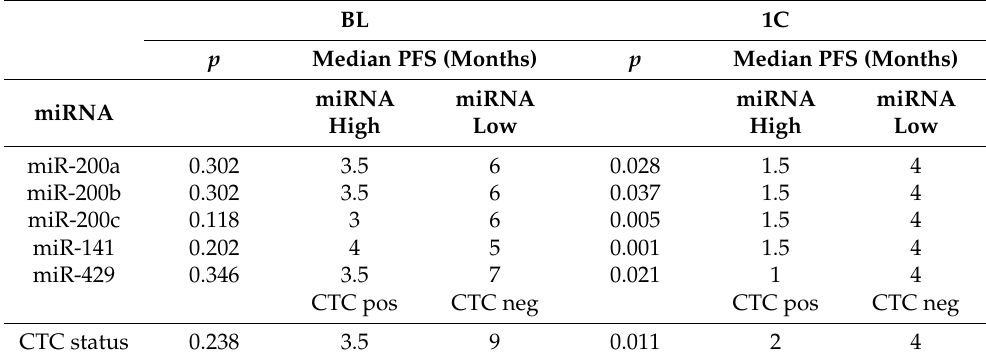
Table 5. Log-rank test comparing PFS distribution among miRNA expression and CTC status. BL 1C p Median PFS